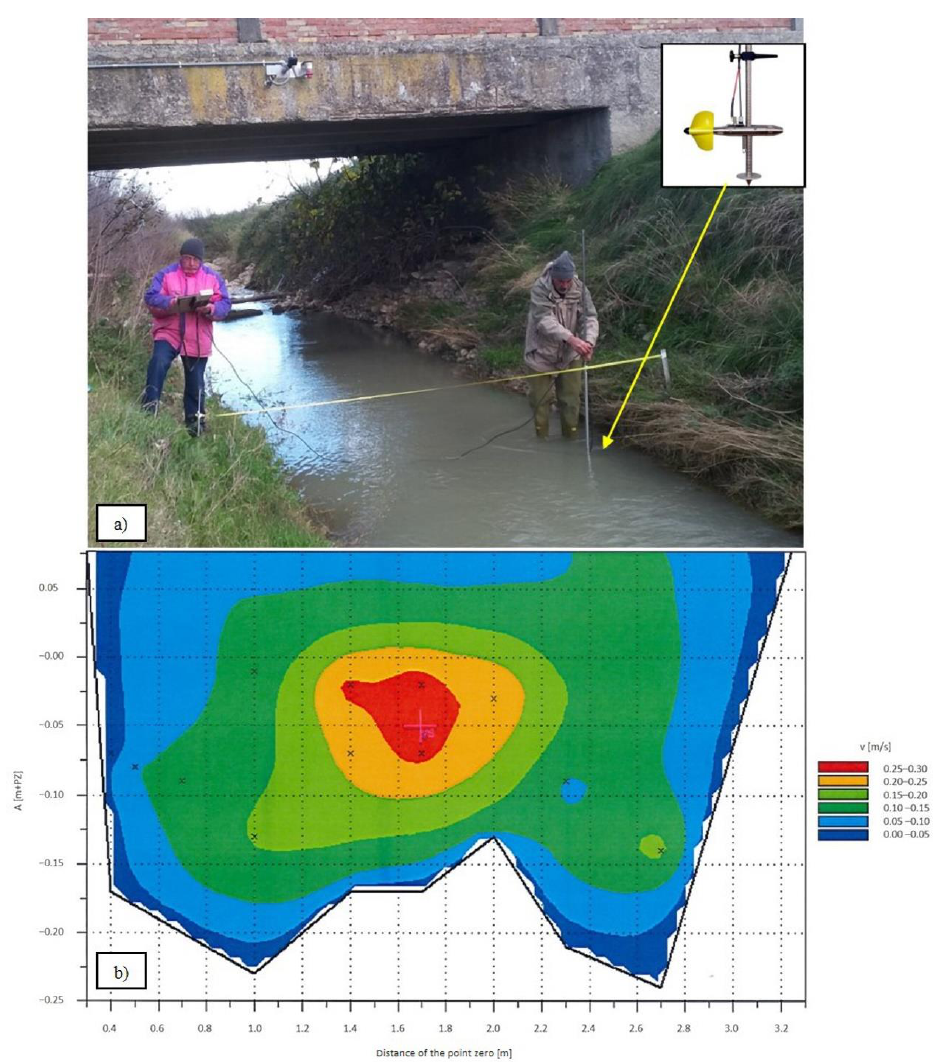
Figure 4. ( a ) Calibration measurements using a current meter ( b ) Isotachs of the analyzed